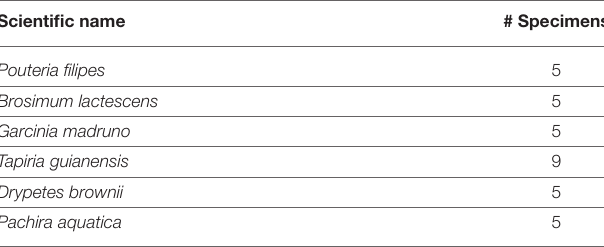
TABLE 2 | Species never correctly identified by the